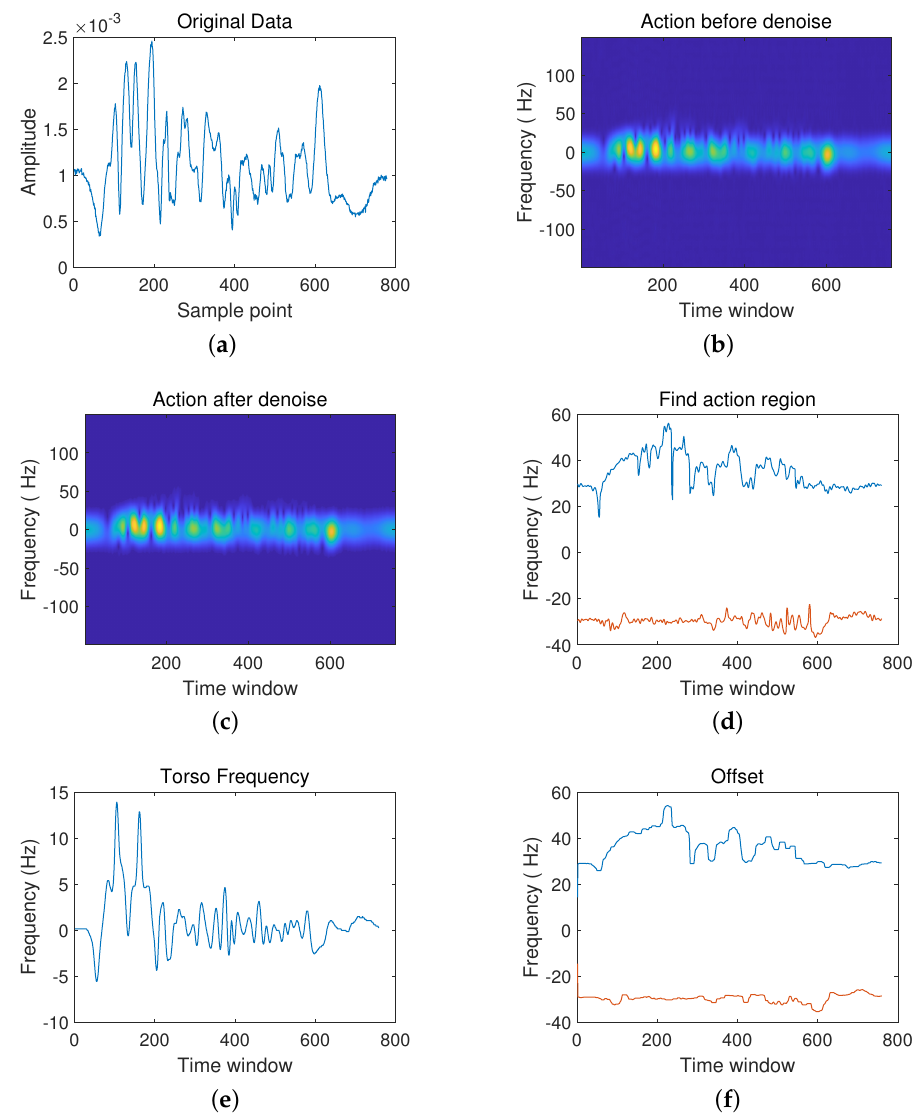
Figure 7. Schematic diagram from sitting to standing. ( a ) The original data.; ( b ) Frequency spectrum diagram before noise reduction; ( c ) Frequency spectrum diagram after noise reduction; ( d ) Action interval; ( e ) Body frequency; ( f )